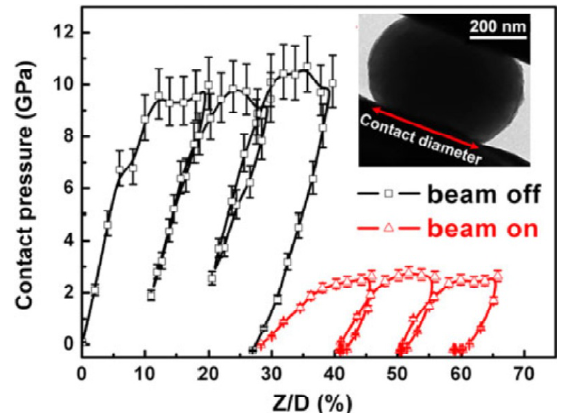
Fig. 5. The effect of E-beam on the mechanical behavior of an amorphous silica particle. The con- tact pressure decreased about four times when elec- tron beam was switched from off (black curve) to on (red curve). The inset is a frame from the recorded movie during compression test. Reprinted